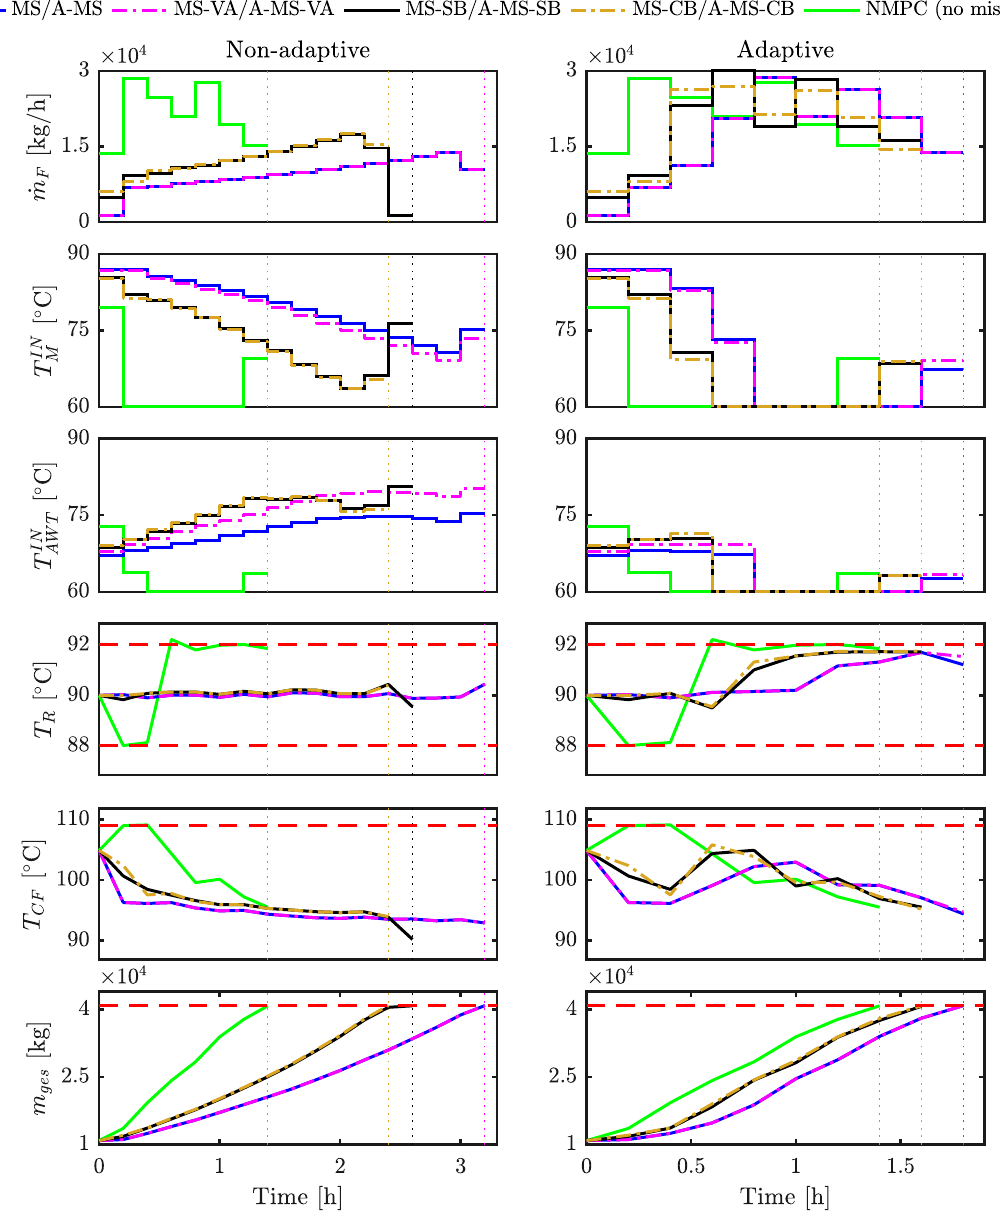
Figure 14. Input feed, temperatures of the coolant entering the jacket and entering the external heat exchanger, temperature of the reaction mixture, maximum attainable reactor temperature in the event of a cooling failure, and mass of the contents inside the reactor with their constraints when the reactor is controlled using the different NMPC controllers in the presence of measurement noise. The dotted vertical lines indicate the end times of the batches. Left figure: The plant is controlled using the non-adaptive approaches explained in Section 3, Right figure: The plant is controlled using the adaptive approaches explained in Section 4. NMPC (no mismatch)—the plant model and the simulation model are